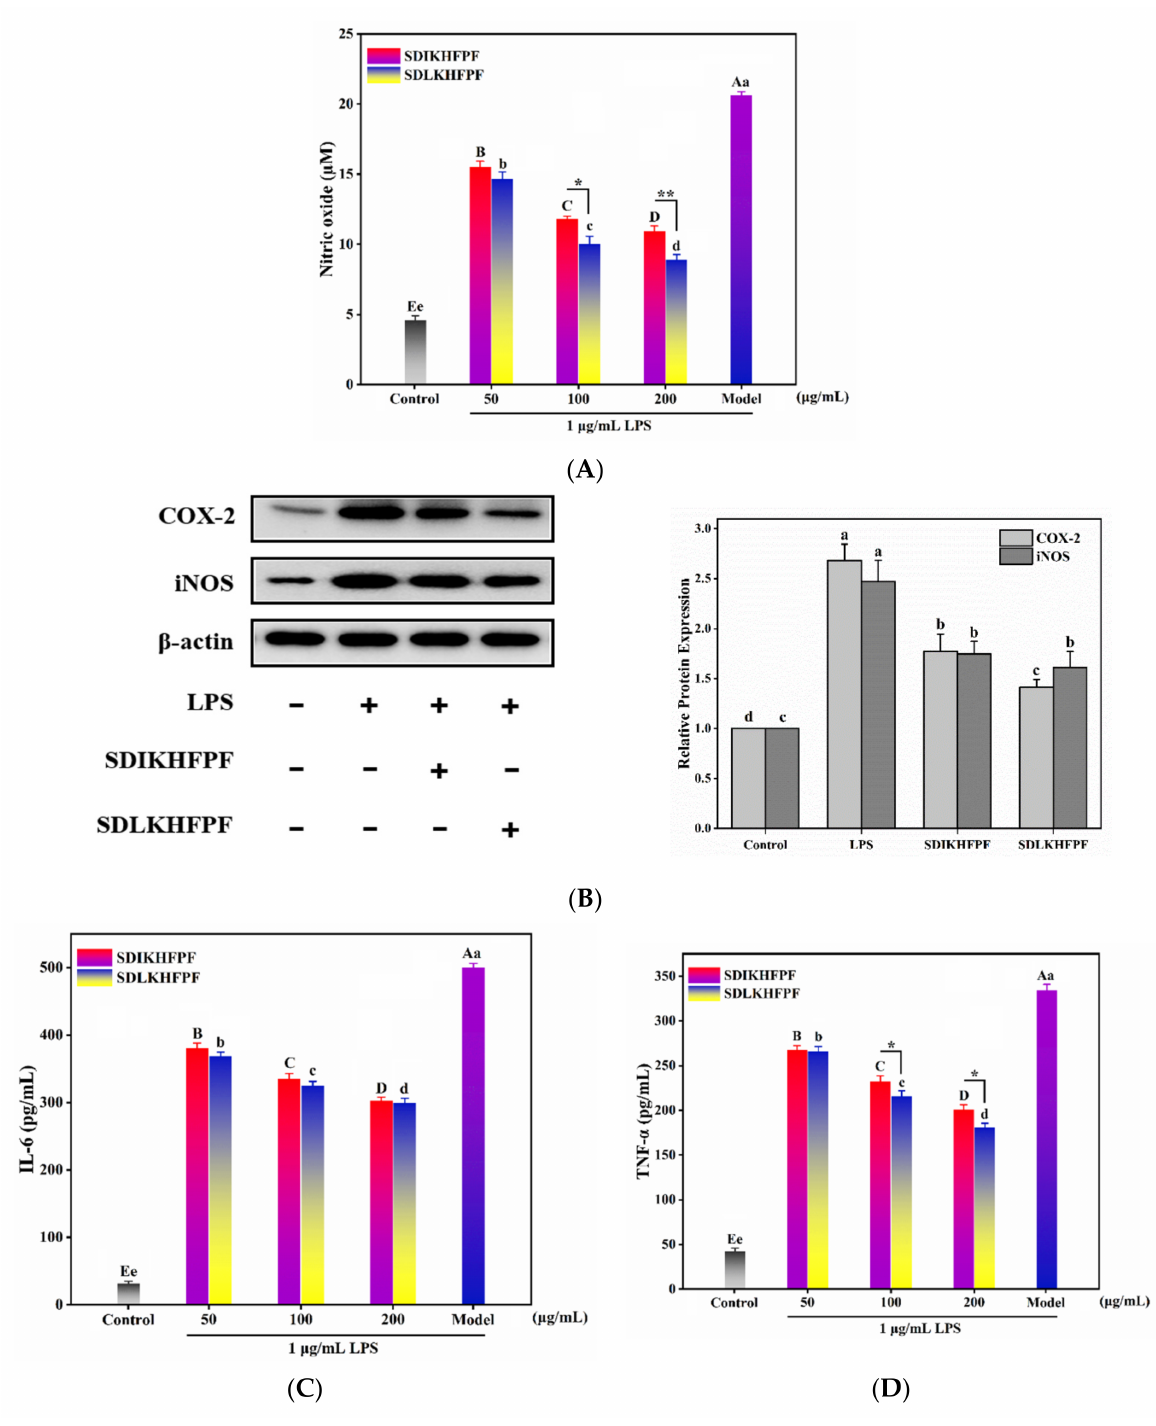
Figure 1. ( A ) Determination of NO production. ( B ) Protein expression of COX-2 and iNOS determined by Western blotting. β -actin was used as a loading control. ( C , D ). Determination of IL-6 and TNF- α contents in the medium supernatants. All of the data shown were the mean ± SD ( n = 3), *: p < 0.05, **: p < 0.01. The different capital letters represent the significant difference for SDIKHFPF ( p < 0.05). The different lowercase letters represent the significant difference for SDLKHFPF ( p <